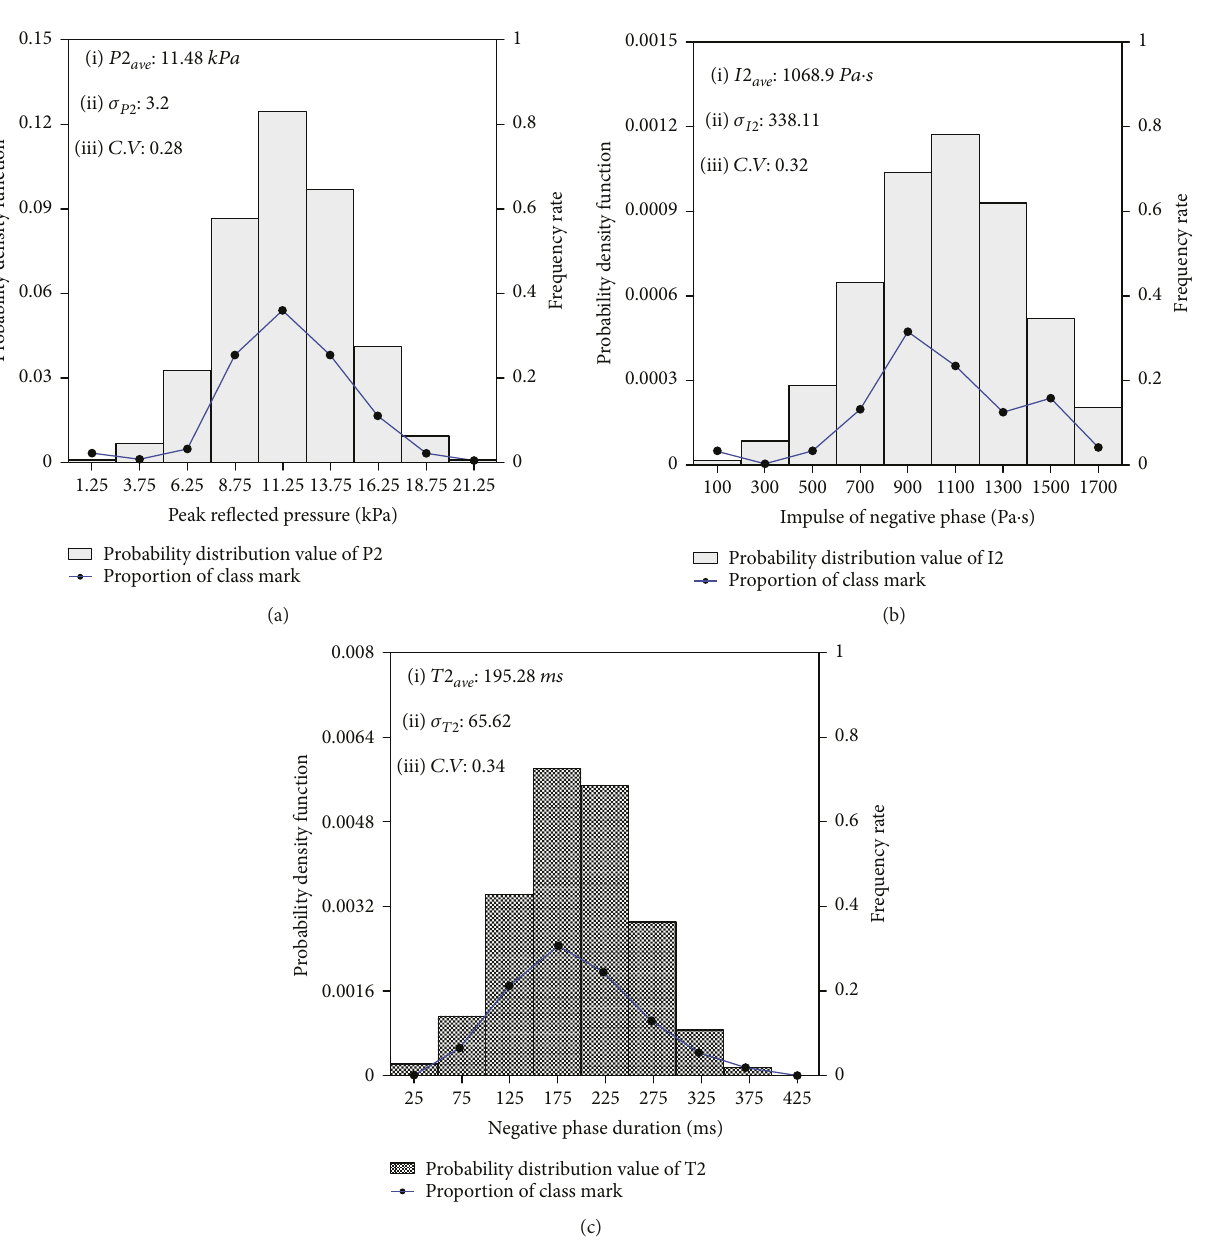
Figure 8: Probability density function for parameters in the negative pressure phase. (a) As for the rebounded peak pressure; (b) as for the impulse; (c) as for the duration